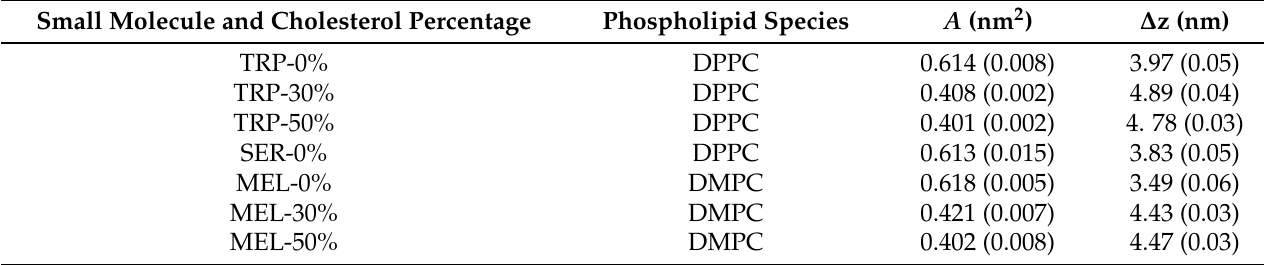
Figure 1. Atomic structures of melatonin, serotonin, tryptophan, dipalmitoylphosphatidylcholine (DPPC), dimyristoylphosphatidylcholine (DMPC), and cholesterol. Backbone hydrogens are not explicitly shown. The highlighted labels will be referred in the text. Table 1. The averaged area per lipid ( A ) and thickness ( ∆ z) of the anionic membrane for the systems studied in this work. Estimated errors in parenthesis. Data are partially taken from Refs.